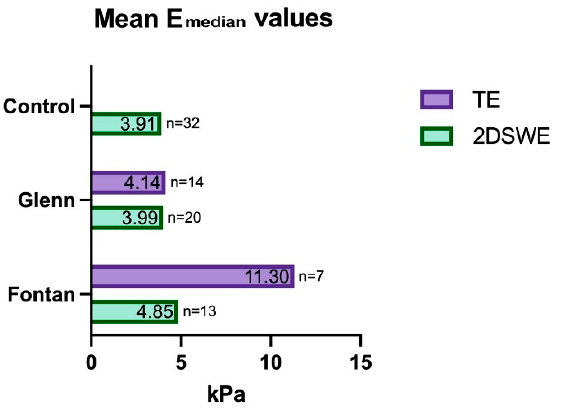
Figure 2. Mean E median Values determined by TE and SWE. Table 2. Comparison between the three groups—elastography and biomarker results.